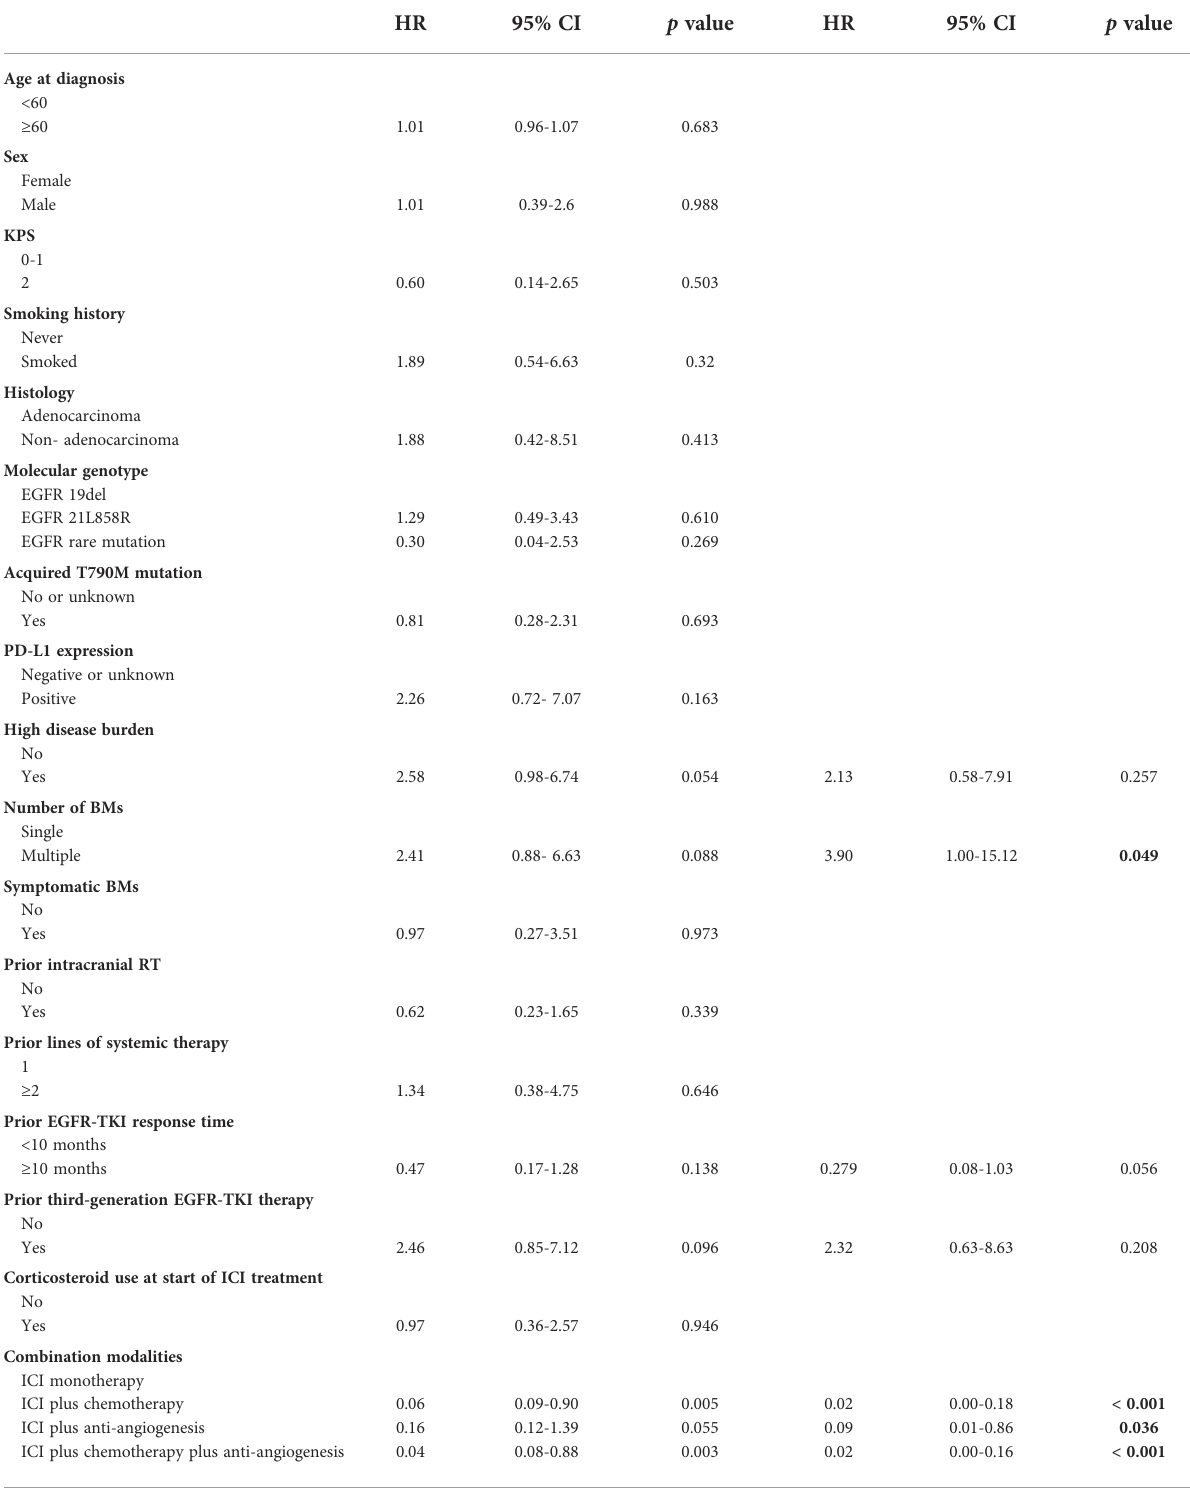
TABLE 5 Univariate and multivariate survival analyses of intracranial